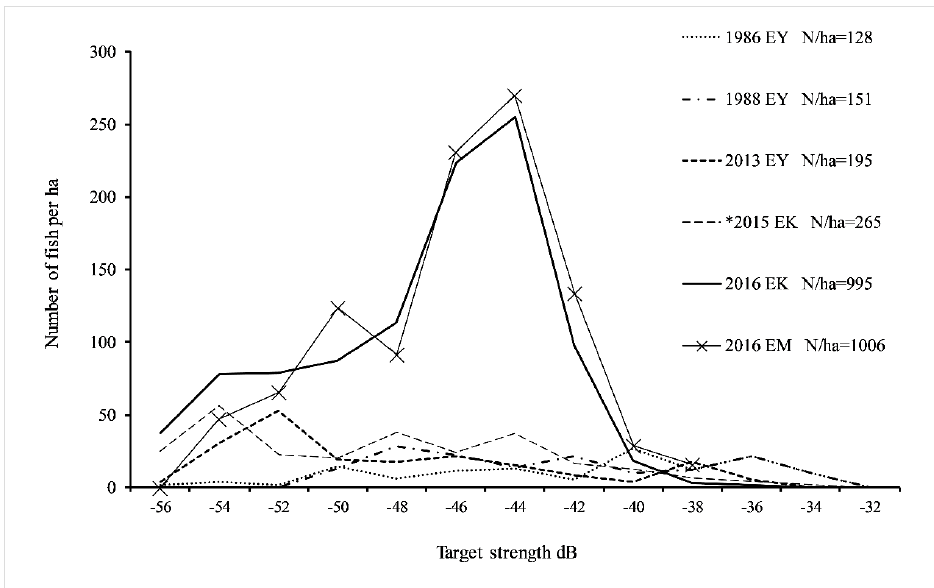
Figure 6. Estimated total density at 2 – 50 m depth from six surveys in Lake Storsjøen during 1986 to 2016. All surveys except *2015 were done during daytime in May (* = night in September).